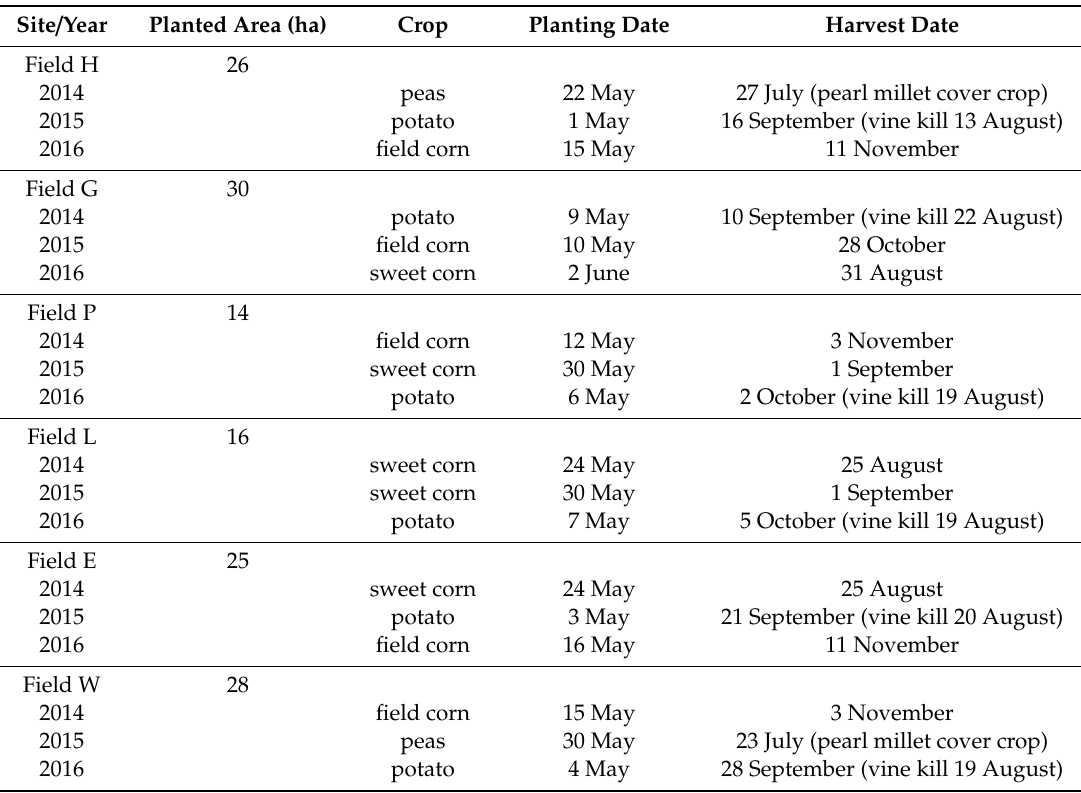
Table 1. Cropping